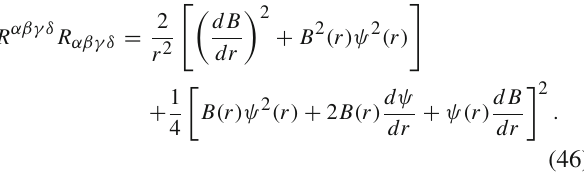
the Kretschmann scalar associated to the line element (44) is given